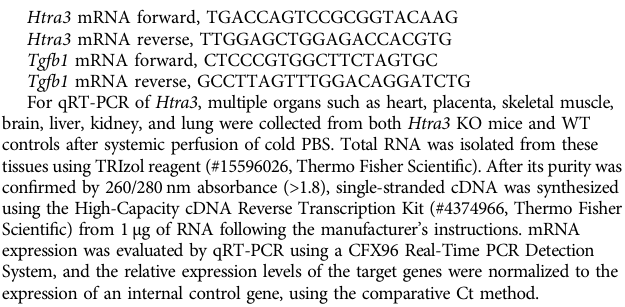
Fig. 7 Single-cardiomyocyte RNA-seq and plasma proteome analysis of patients with heart failure. a UMAP plot of single-cell transcriptomes of cardiomyocytes isolated from control subjects (CTL) or patients with heart failure (HF) ( n = 85 cells for CTL, n = 678 for HF). b Trajectory analysis on the UMAP plot in a . Clusters classi fi ed by graph-based clustering are shown by colors. Trajectories identi fi ed by the Slingshot algorithm are also shown. c Bar graph showing the distribution of the clusters in b . d M2 expression on the UMAP plot (left) and its dynamics along pseudotime (upper right). Enriched GO terms are also shown (lower right). e Heatmap showing the expression levels of selected M2 genes during the trajectories. f Boxplot of the M2 expression. Data represent box plots and individual data points. Box plots show the median (center line), fi rst and third quartiles (box edges), while the whiskers going from each quartile to the minimum or maximum. n = 300 for C1, n = 267 for C2, n = 196 for C3. g M1 expression on the UMAP plot (left) and its dynamics during trajectories (upper right). Enriched GO terms and enrichment P -values are also shown (lower right). h Heatmap showing the expression levels of selected M1 genes during the trajectories. i Boxplot of the M1 expression. Data represent box plots and individual data points. Box plots show the median (center line), fi rst and third quartiles (box edges), while the whiskers going from each quartile to the minimum or maximum. n = 300 for C1, n = 267 for C2, n = 196 for C3. j Scatter plot showing the ME expression of M1 and M2 for each cell. k M44 expression on the UMAP plot (left) and its dynamics along pseudotime (upper right). Enriched GO terms are also shown (lower right). l Heatmap showing the expression levels of selected M44 genes during the trajectories. m Boxplot of the M44 expression. Data represent box plots and individual data points. Box plots show the median (center line), fi rst and third quartiles (box edges), while the whiskers going from each quartile to the minimum or maximum. n = 300 for C1, n = 267 for C2, n = 196 for C3. n Boxplot of plasma protein levels of IGFBP7 (upper) and NT-proBNP (lower). RFU, relative fl uorescence unit. HF, heart failure. HTx, heart transplantation. Data represent box plots and individual data points. Box plots show the median (center line), fi rst and third quartiles (box edges), while the whiskers going from each quartile to the minimum or maximum. n = 768 for Control, n = 85 for non-advanced HF, n = 30 for advanced HF before HTx, n = 30 for advanced HF after HTx. o Mean decrease in accuracy (in order of decreasing accuracy from top to bottom) of proteins involved in classi fi cation between manifest and advanced heart failure as assigned by the random forest classi fi er. p Receiver-operating characteristic (ROC) curves based on plasma protein levels of NT-proBNP and IGFBP7 for predicting the incidence of heart failure. Area under the curve is also shown for each marker. NT-proBNP had signi fi cantly better ability to diagnose heart failure ( P -value = 1.109e-07). Areas under the ROC curve were calculated using logistic regression. q ROC curves based on plasma protein levels of NT-proBNP and IGFBP7 for discriminating patients with advanced heart failure. Area under the curve is also shown for each marker. Although not statistically signi fi cant, IGFBP7 had a higher power to determine the severity of heart failure ( P -value = 0.1063). Areas under the ROC curve were calculated using logistic